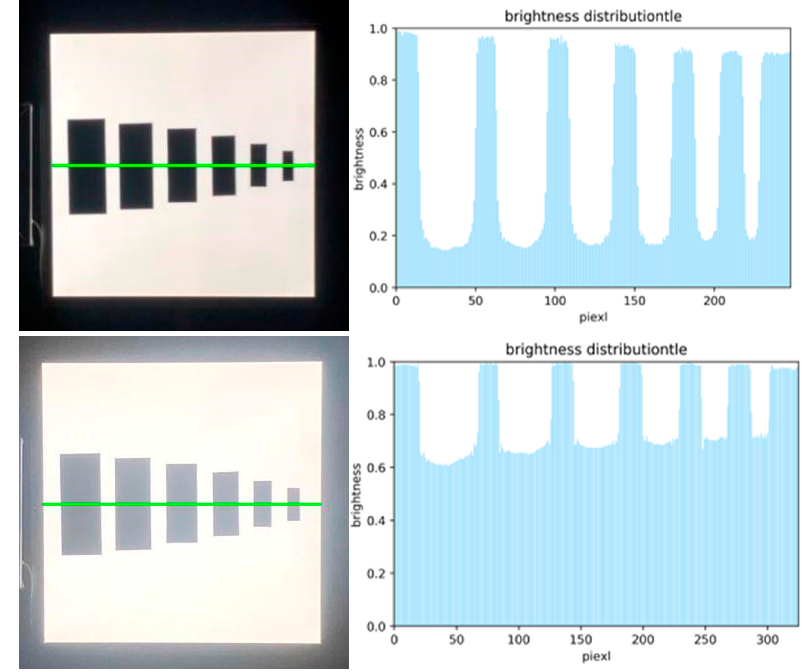
Figure 6. Horizontal brightness histogram of the target.